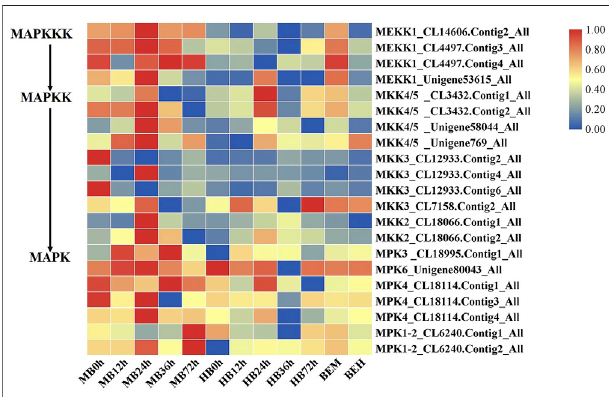
FIGURE 5 | Differential gene expression pro fi les involved in MAPK Signaling pathway. MB represents plants were pre-treatment with melatonin and then inoculated with B. elliptica ;HBrepresentsplantswerepre-treatment with Milli-Q water [ethanol/water (v/v) D 1/10,000], and then inoculated with B. elliptica . BEM represents plants were inoculated with B. elliptica for 36 h and then treated with 100 ml melatonin (2 mM/L) for 36 h; BEH represents plants were inoculated with B. elliptica for 36 h and then treated with 100 ml Milli-Q water [ethanol/water (v/v) D 1/10,000] for 36 h.